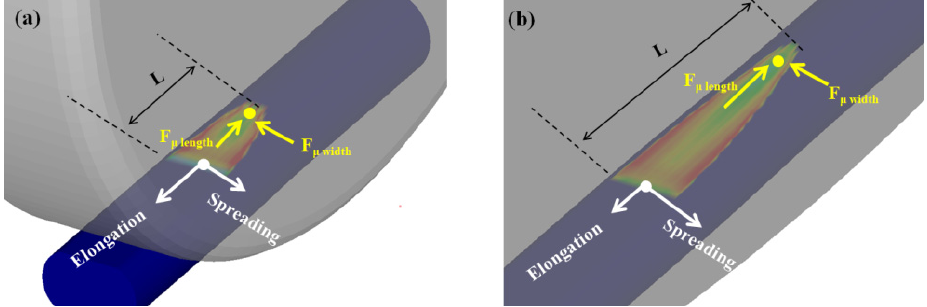
Figure 14. Schematic illustration of the frictional effect at the wire and roll interface with ( a ) small roll and ( b ) large roll during wire flat rolling.